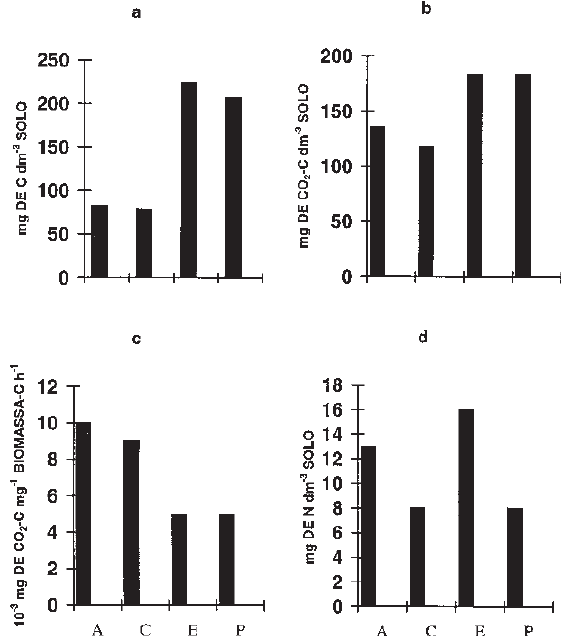
Figura 1. Biomassa microbiana de carbono (a); respiração acumulada (b); taxa de respiração específica da biomassa microbiana (c), e biomassa microbiana de nitrogênio (d) dos solos sob angico (A), capoeira (C), eucalipto (E) e pinheiro